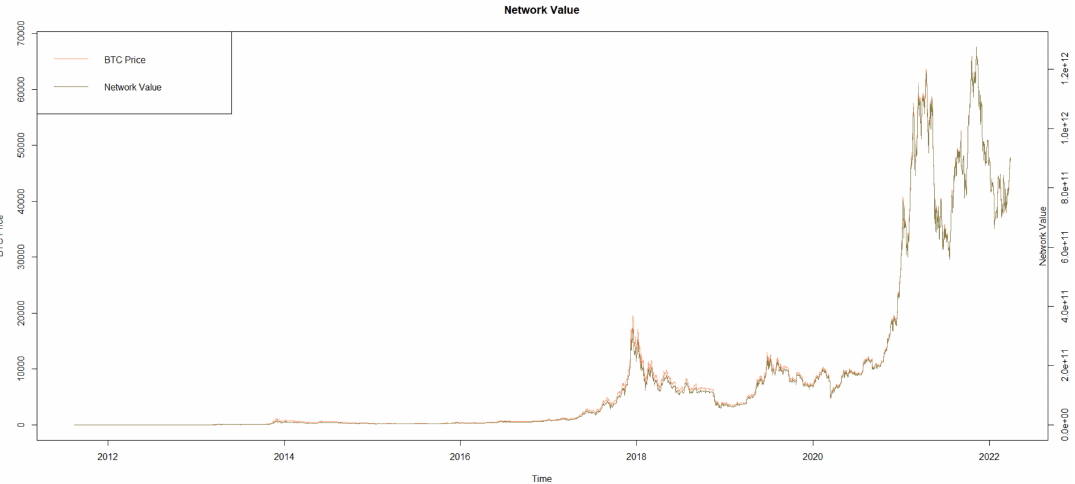
Figure 1. Bitcoin price and network value.